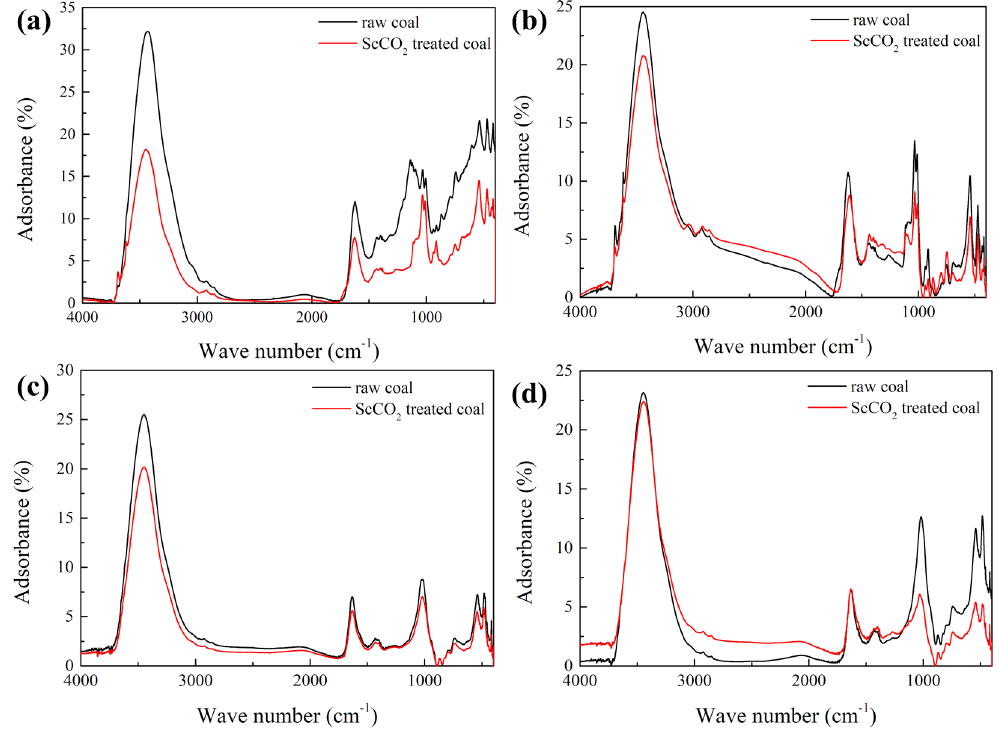
Figure 3. Fourier transform infrared spectroscopy (FTIR) spectra for the raw and ScCO 2 -treated coal samples: ( a ) DL coal; ( b ) ZL coal; ( c ) GY coal; ( d ) DT coal.